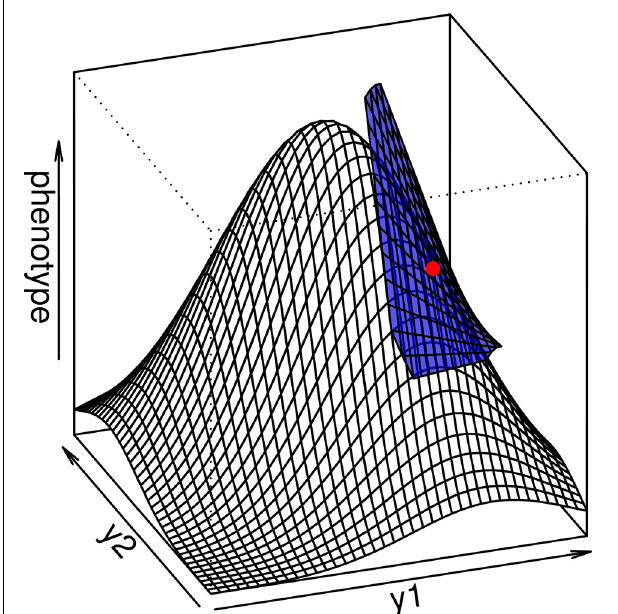
FIGURE 2 | The multilinear model (blue surface) is a local approximation of the interlocus curvature in a complex genotype-phenotype map. When the average genotype is chosen as the reference (red point), the multilinear approximation is able to predict the evolutionary properties of the population in a more precise way than the additive model.